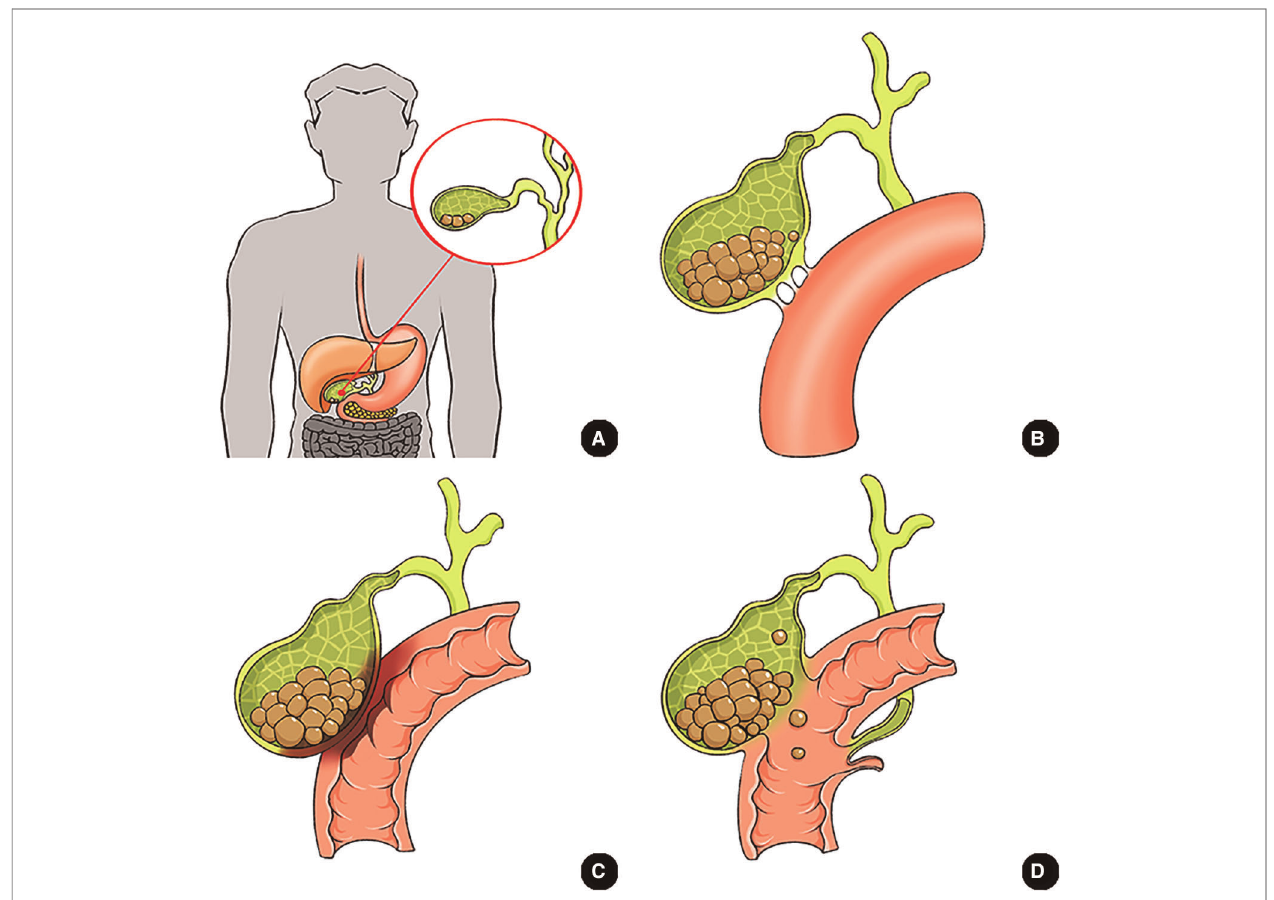
FIGURE 4 | Schematic diagram of the formation of CEF with GI. (A) gallstones; (B) Dense adhesion between gallbladder and duodenum; (C) Compression of ful fi lled gallstones cause tissue ischemia, necrosis and erosion; (D) Fistula formation and gallstones migrate into digestive tract causing gallstone